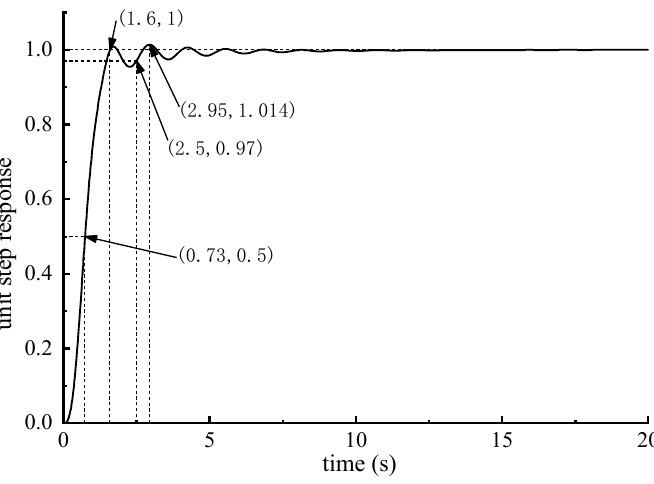
Figure 5. Simulation waveform of PID control.